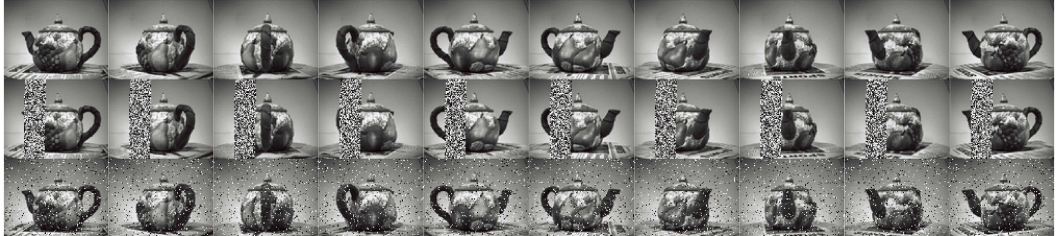
Figure 6. Ten teapot images, their corresponding outlier images and noise-corrupted